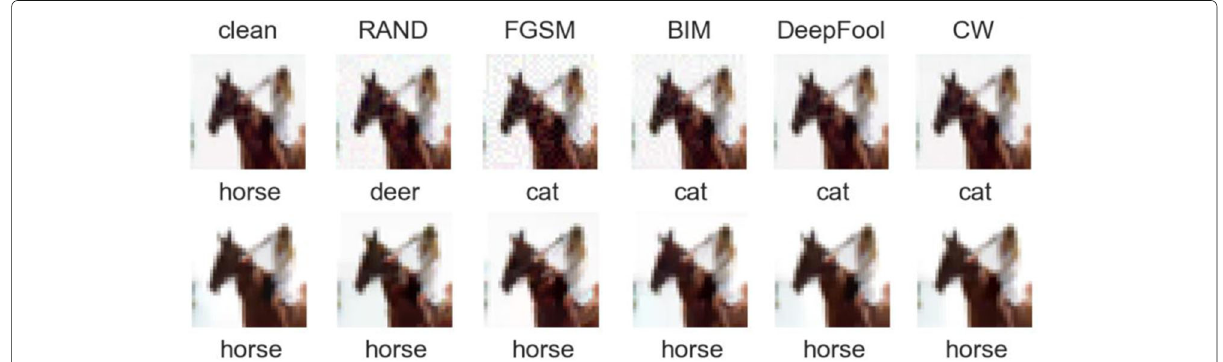
Fig. 11 The example for PixelDefend (Song et al. 2017). The first image denote the original clean image in CIFAR-10 (Krizhevsky et al. 2014), and the remaining pictures represent the adversarial examples based on varieties attack methods which have been shown above each example, and the predicted label has been shown on the bottom. Meanwhile, the second line denotes the corresponding purified